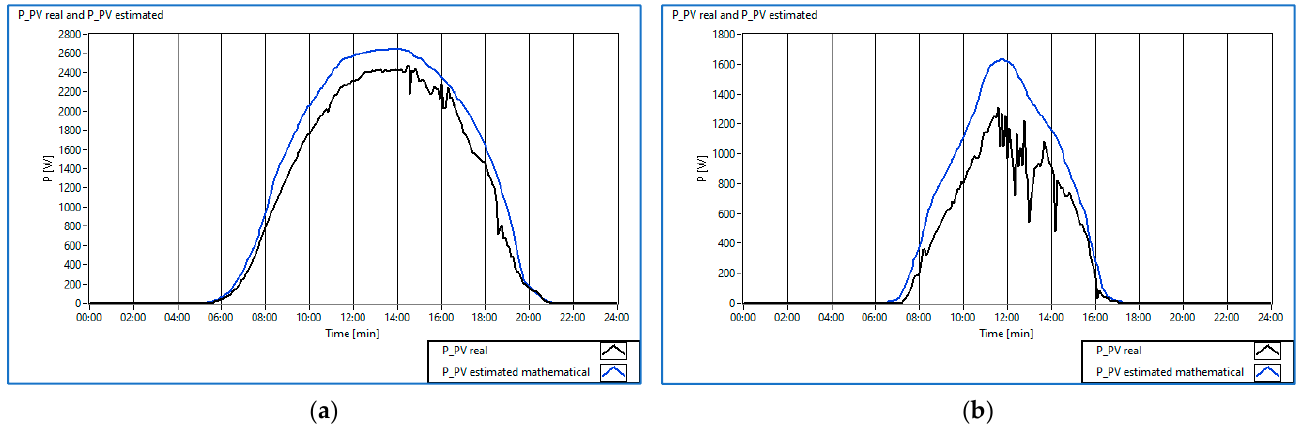
Figure 6. P PV real and P PV estimated with mathematical model for: ( a ) scenario 1; ( b ) scenario 2.